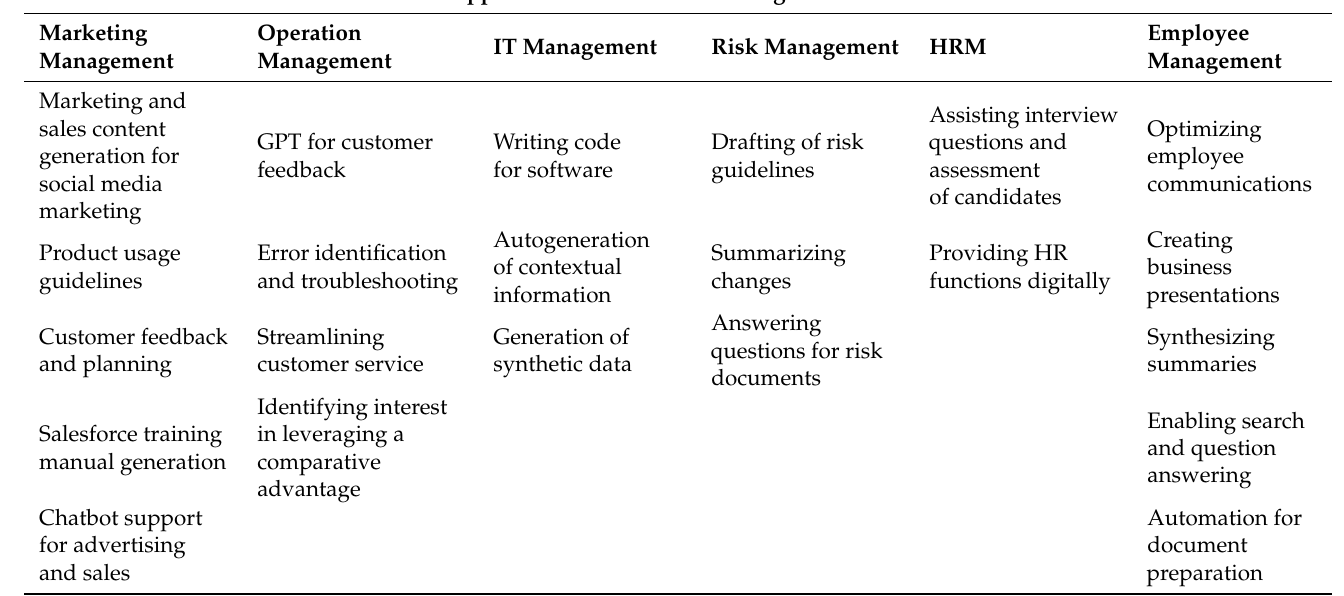
Table 2. GAI applications in different management fields for